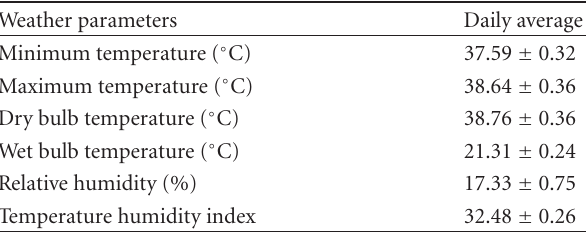
Table 1: Mean and SEM of meteorological data during the study